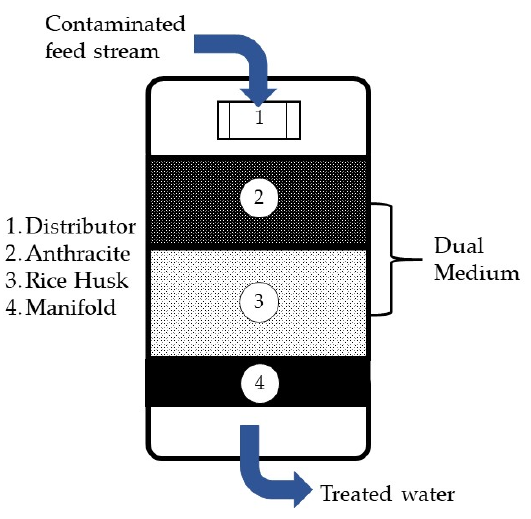
Figure 1. Structure of the bio filter.